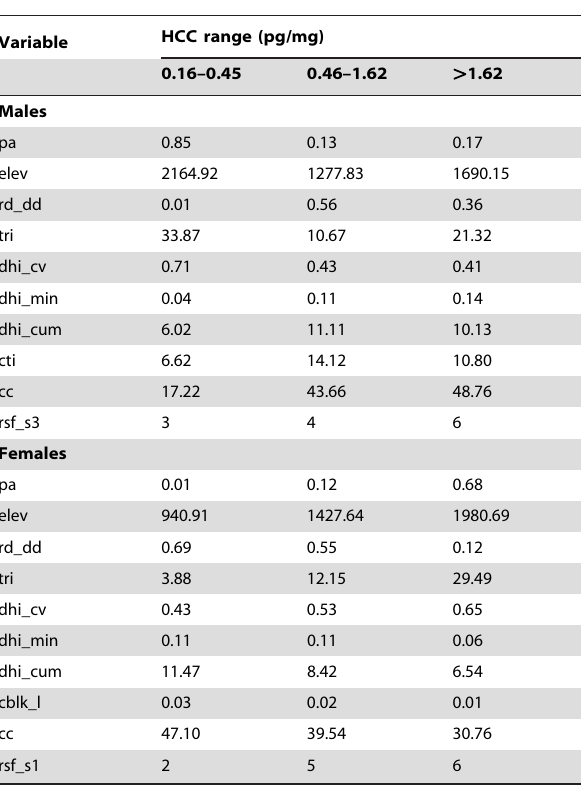
Table 3. Mean values of the 10 most influential variables in the total random models associated with lower, mid, and upper quartiles of the predicted HCC levels in male and female grizzly